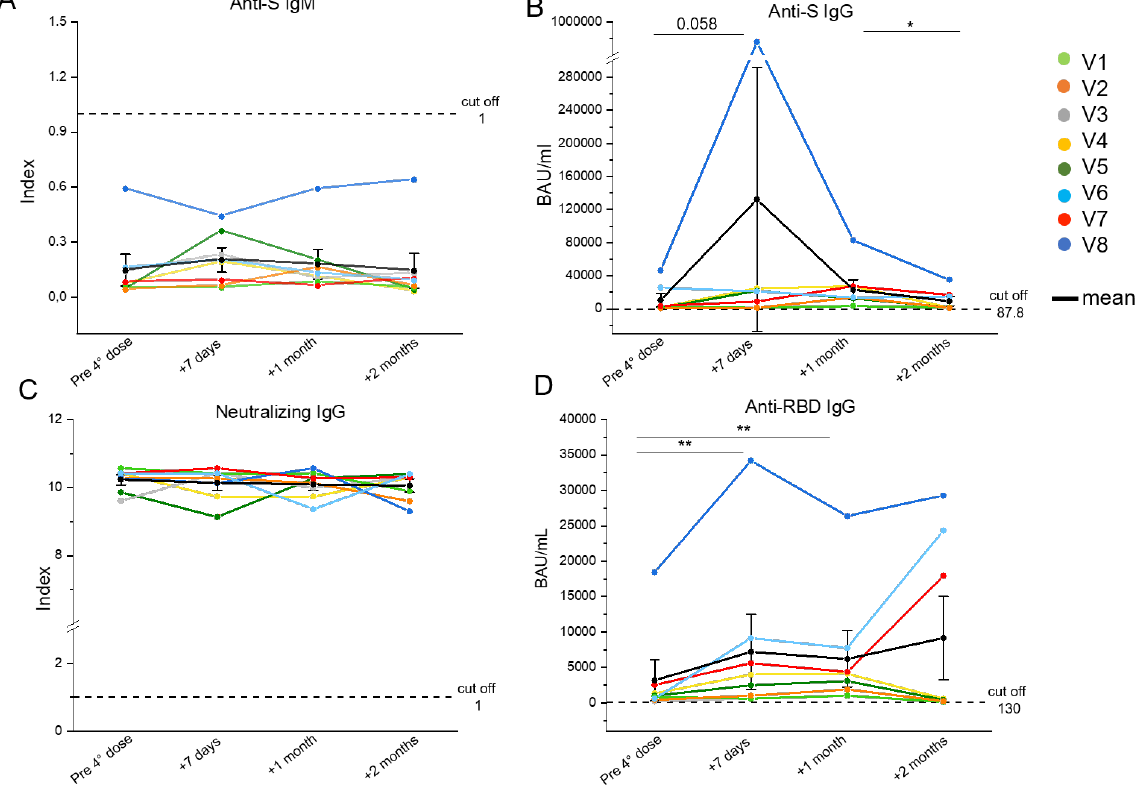
Figure 1. Evaluation of the SARS-CoV-2-specific humoral response in eight people living with HIV (PLWH) up to 2 months after the fourth vaccine dose . Anti-S IgM (cut off = 1) ( A ), anti-S IgG (cut off = 87.8) ( B ), neutralizing IgG (cut off = 1) ( C ), and anti-RBD IgG (cut off = 130) ( D ) serum levels were evaluated in PLWH before, one week, one month and two months after the fourth vaccine dose. Each color corresponds to a different subject. Black dots indicate mean values. * p ≤ 0.05, ** p ≤ 0.005. Error bars indicate SE values.